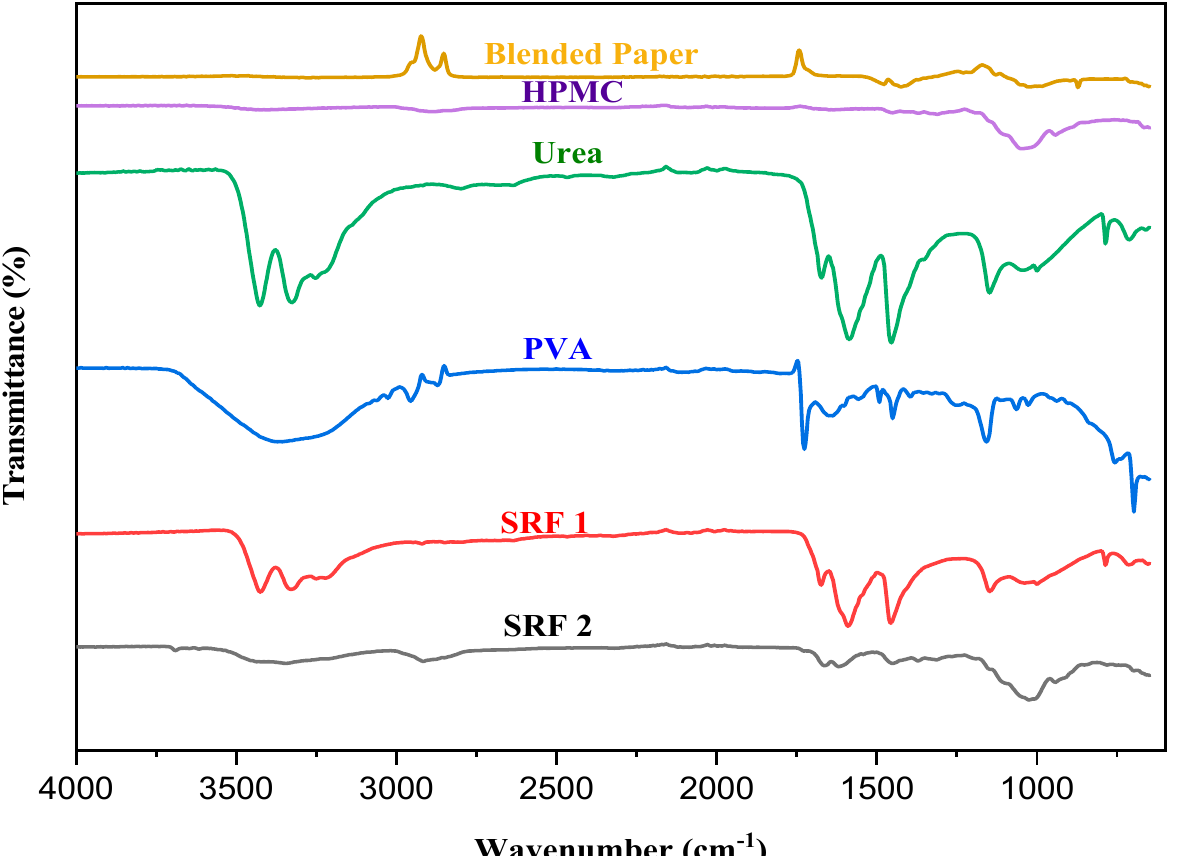
Figure 2. Overlay FTIR spectra of Blended paper, HPMC, Urea, PVA, SRF 1 and SRF 2.